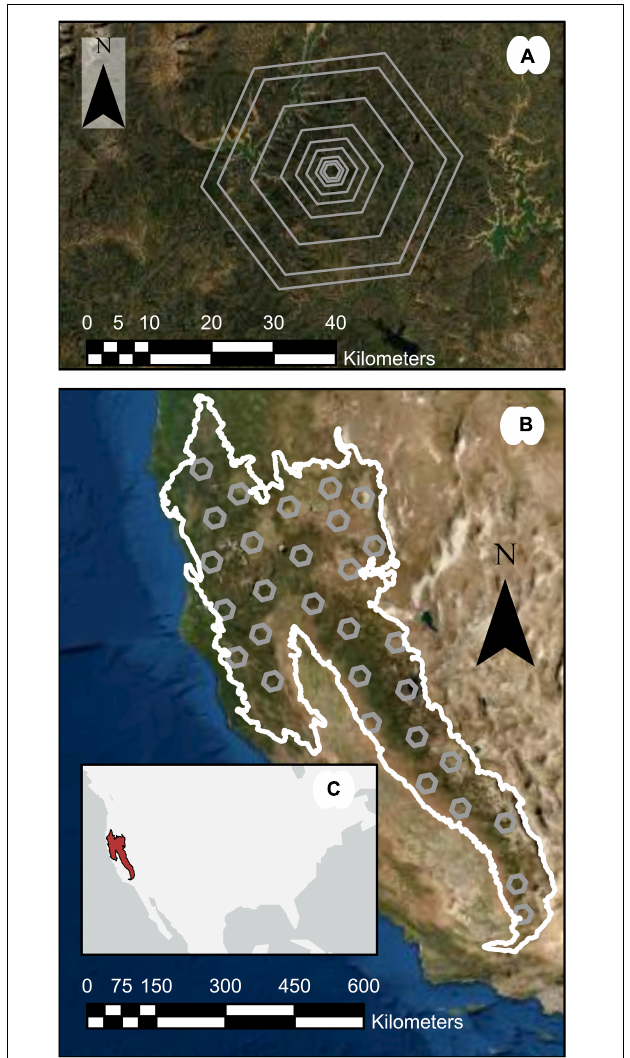
FIGURE 1 | Study region map highlighting (A) nested hexagonal areas of interest, (B) 1,000,000-ha subregions within M261, and (C) an inset showing the study region location in the United